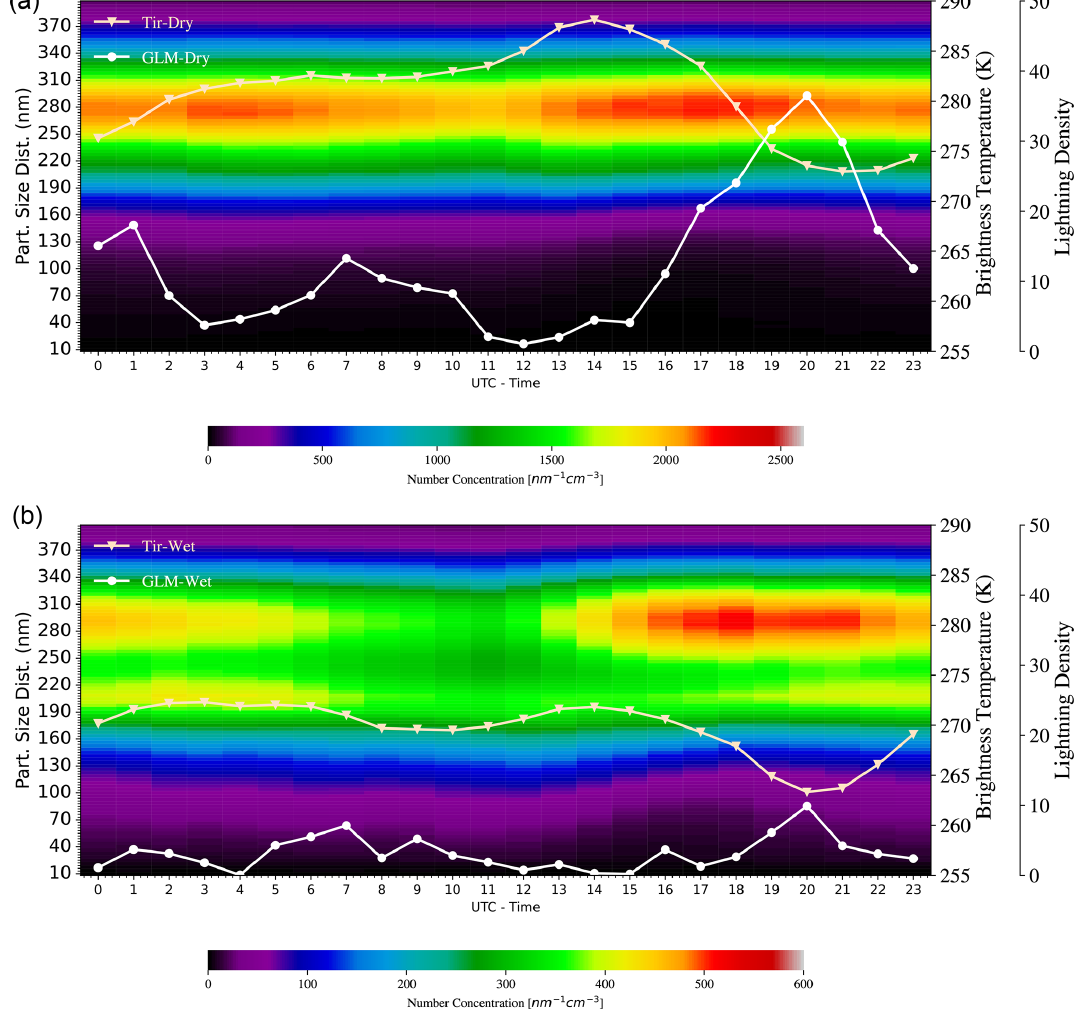
Figure 4. Diurnal cycle of the particle size distribution at ATTO (60m sampling height) during the dry season (June–October) (a) and wet season (December–April) (b) . The monthly mean brightness temperature and lightning density (number of lightning events in 5min in 50 × 50km 2 ) are plotted as white and gray lines with solid lines. Time is UTC; LST is UTC − 4h.